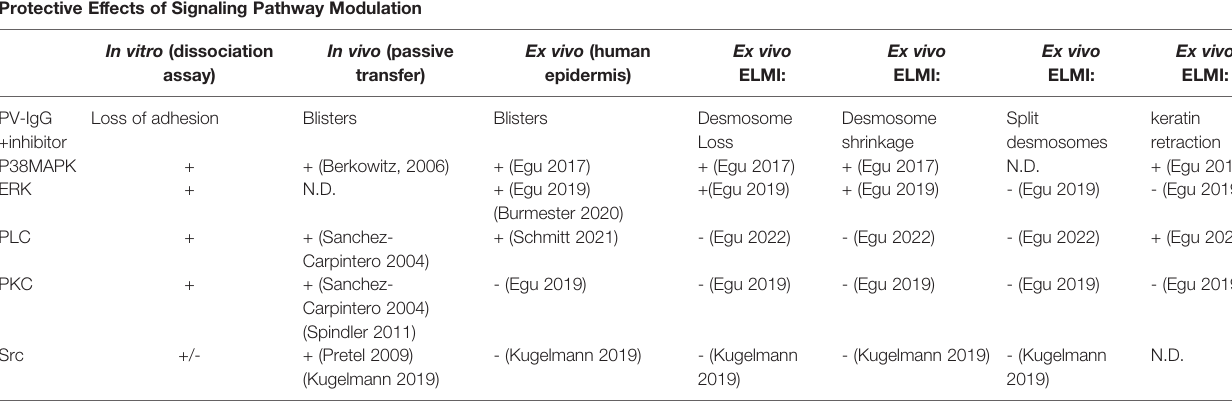
TABLE 1 | Protective effects of signalling pathway